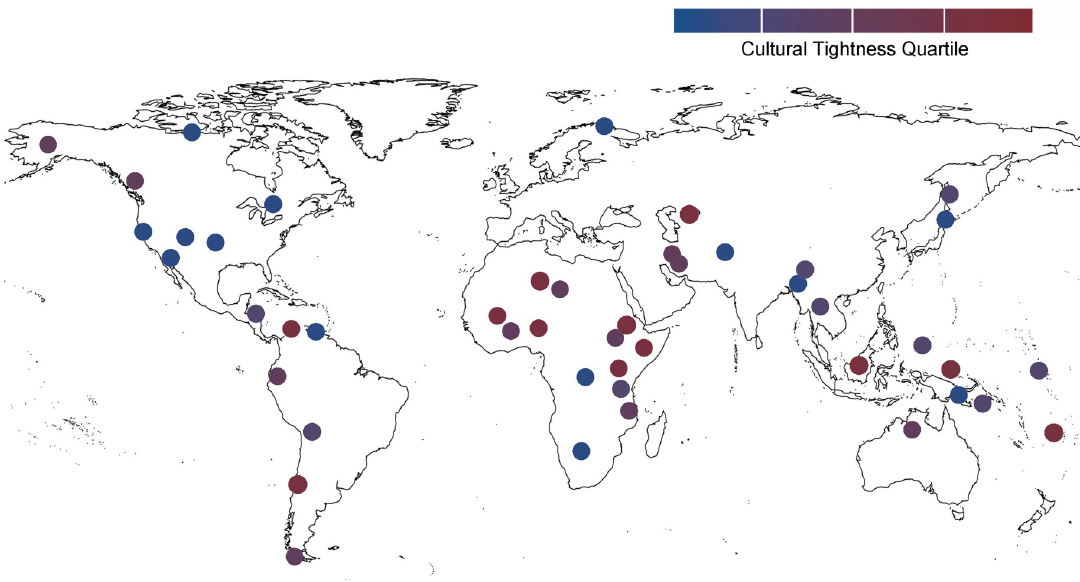
Fig 4. The sample of societies in Study 4. Each node represents a society. Societies are shaded based on their cultural tightness quartile such that the loosest societies are blue and the tightest societies are red.